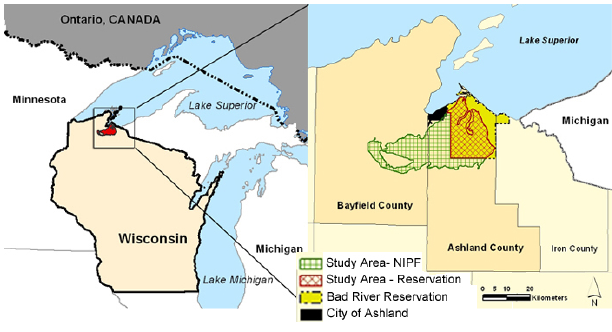
Fig. 2. Location of the northern Great Lakes-Wisconsin study area and land ownerships of the Bad River Indian Reservation and nonindustrial private forest